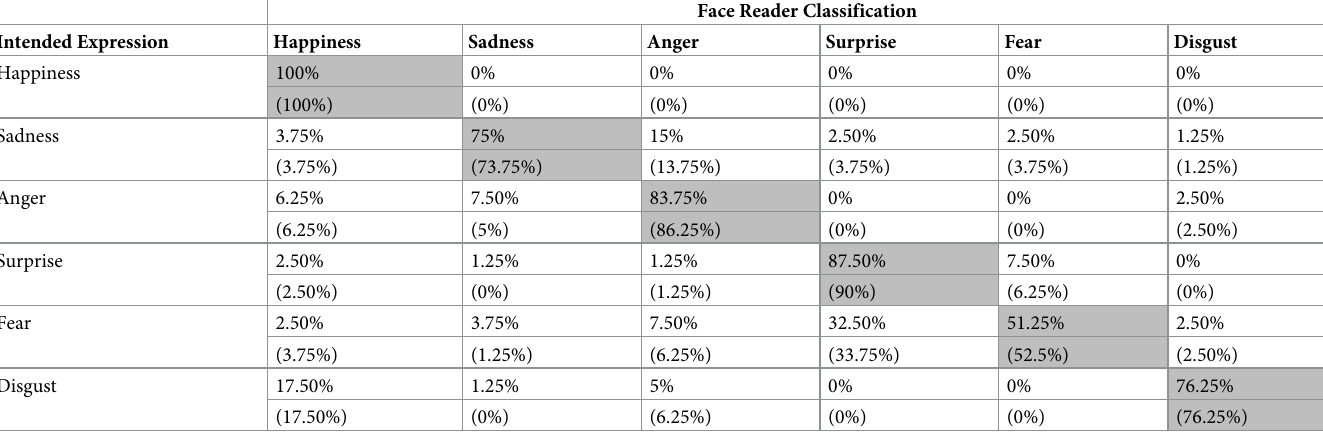
Table 1. Confusion matrix for the intended emotional expressions and the Face Reader (FR) classifications without and with prior calibration of the software.